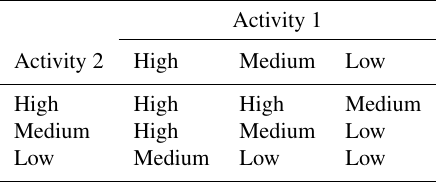
Table 6. Comprehensive activity level of landslide (Lin, 2017).